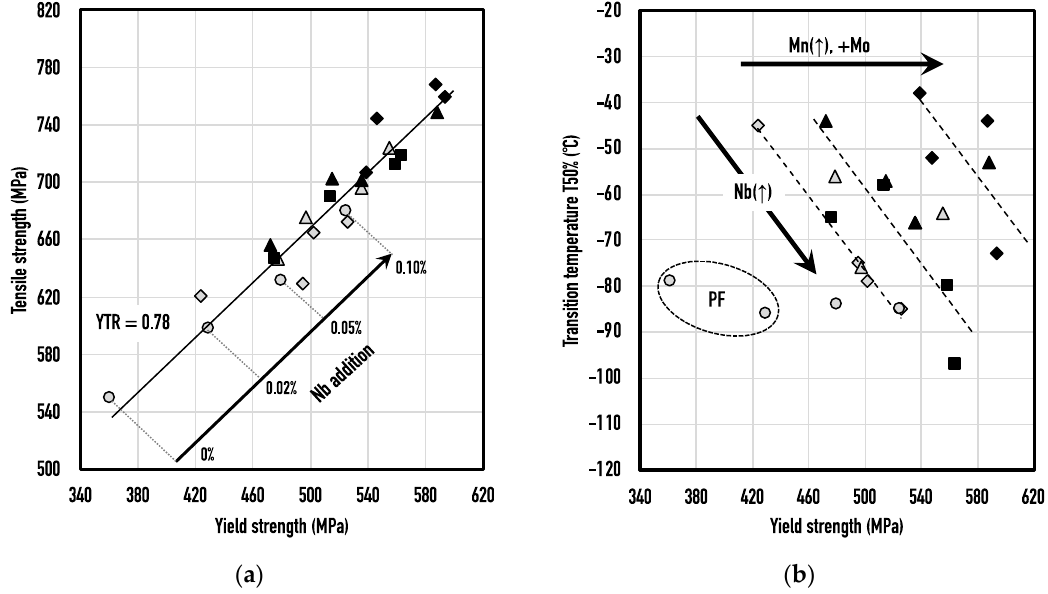
Figure 2. Properties of the as-rolled materials: ( a ) Relationship of yield strength (R p0.2 ) and tensile strength; ( b ) ductile-to-brittle transition temperature (50%) determined by Charpy testing (PF: polygonal ferrite matrix, all other acicular ferrite matrices).